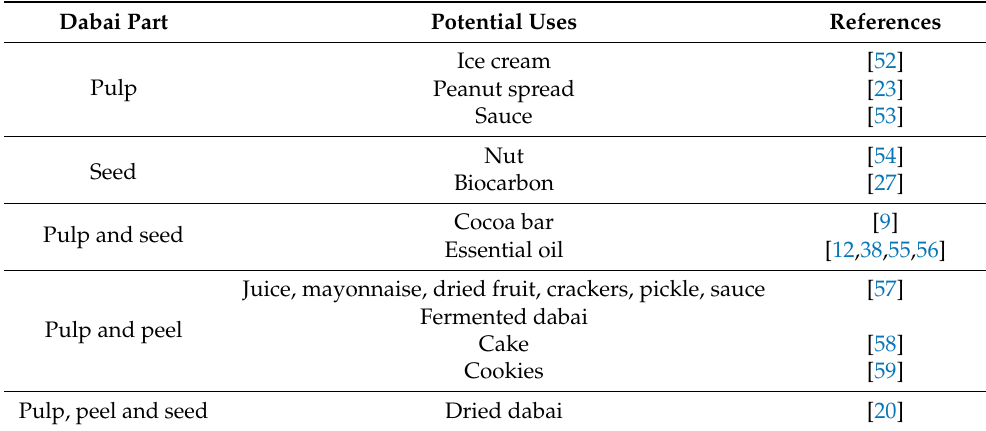
Table 3. The potential food-based and waste-processing products related to